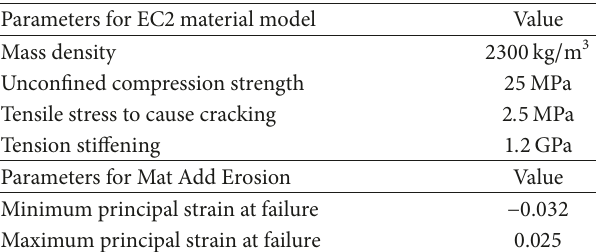
Table 4: Parameters for EC2 material model and Mat Add Erosion formulation for